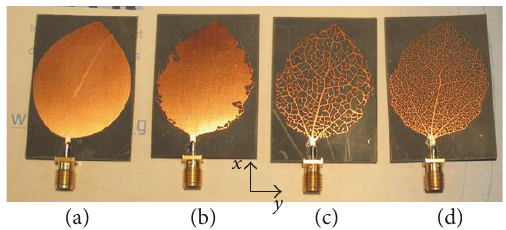
Figure 3: Antenna prototypes: (a) iteration IT0 (A0), (b) iteration IT1 (A1), (c) iteration IT2 (A2), and (d) iteration IT3